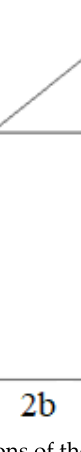
Figure 2. Dimensions of the analyzed building partition.